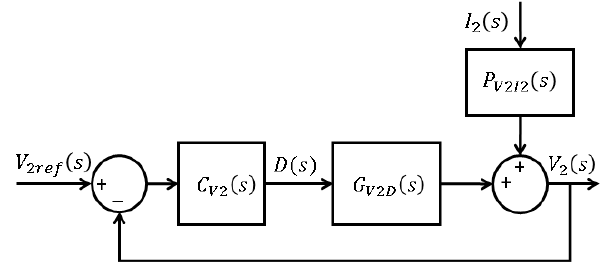
Figure 4. Block diagram of the voltage regulation loop of the converter operating in boost mode.